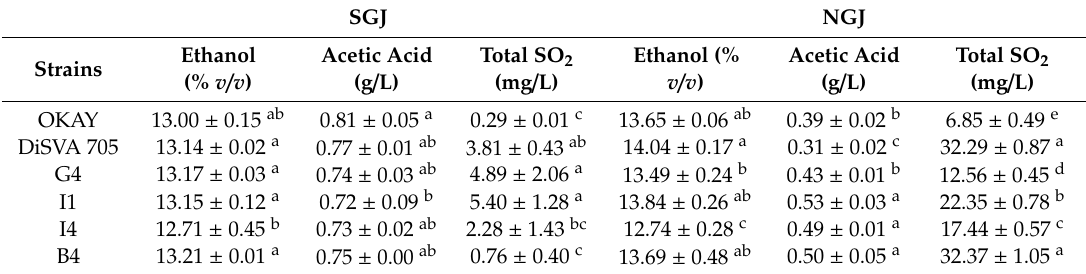
Table 2. The main analytical compounds of wines obtained from S. cerevisiae strains of this study. SGJ NGJ Ethanol Acetic Acid Total SO 2 Ethanol (% Acetic Acid Total SO 2 Strains v / v ) (% v / v ) (g / L) (mg / L) (g / L) (mg / L) OKAY 13.00 ± 0.15